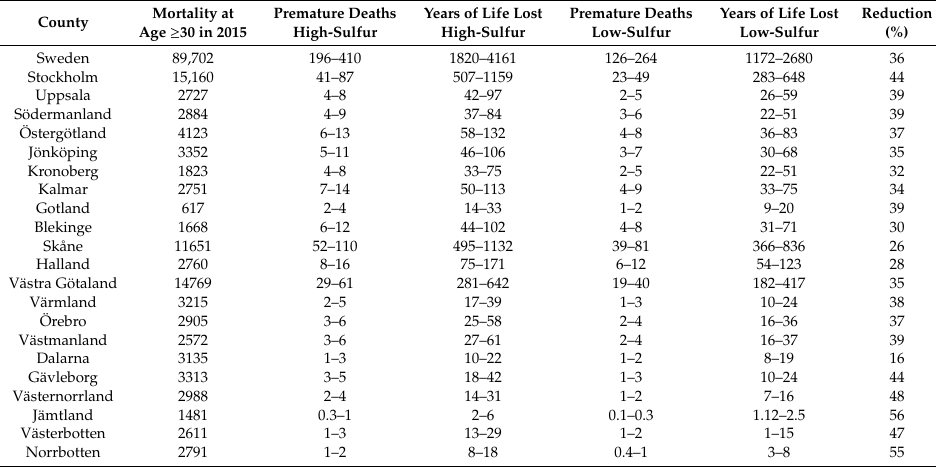
Table 3. Estimated number of premature deaths due to PM 2.5 emissions from Baltic shipping at the regional model in the high- and low-sulfur scenarios according to HRAPIE and ESCAPE exposure–response (ER) functions.